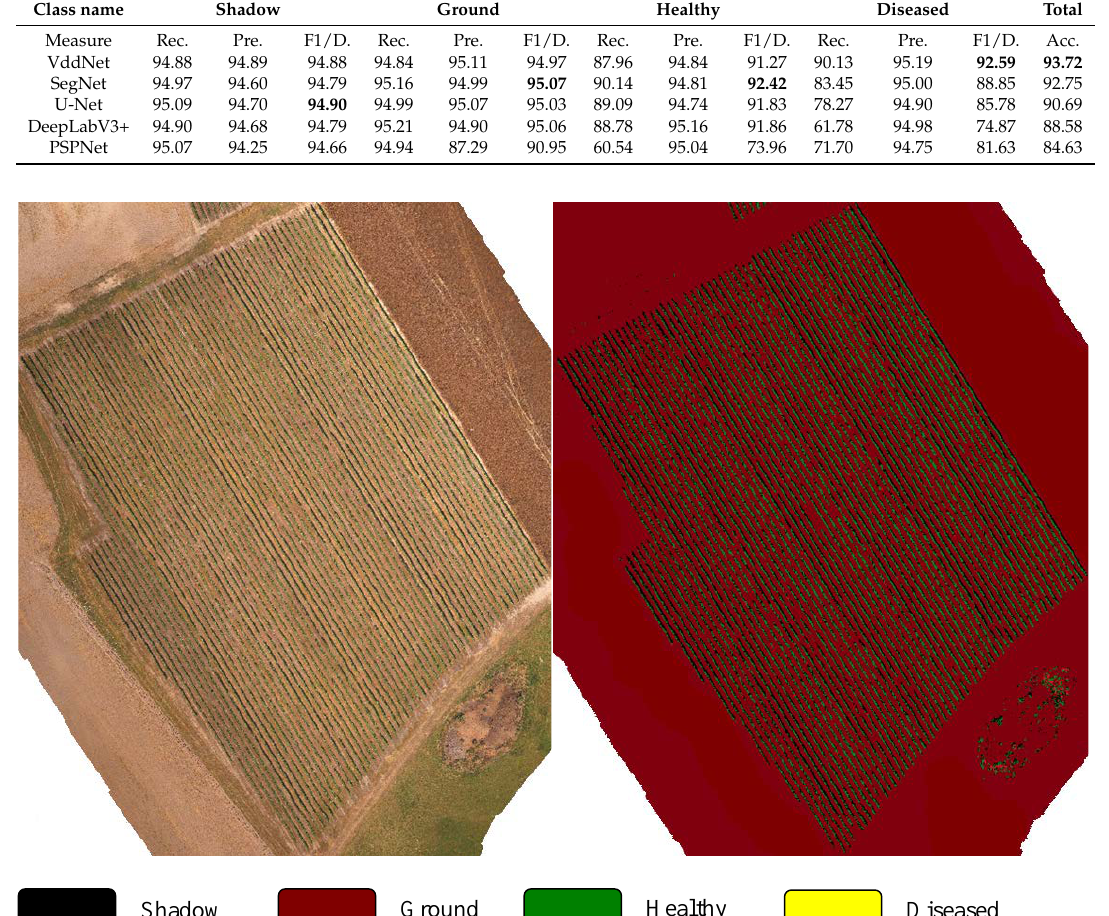
Table 3. Quantitative results with measurement of recall (Rec.), precision (Pre.), F1-Score/Dice (F1/D.) and accuracy (Acc.) for the performances of VddNet, SegNet, U-Net, DeepLabv3+ and PSPNet networks, using multispectral and depth map data. Values are presented as a percentage.